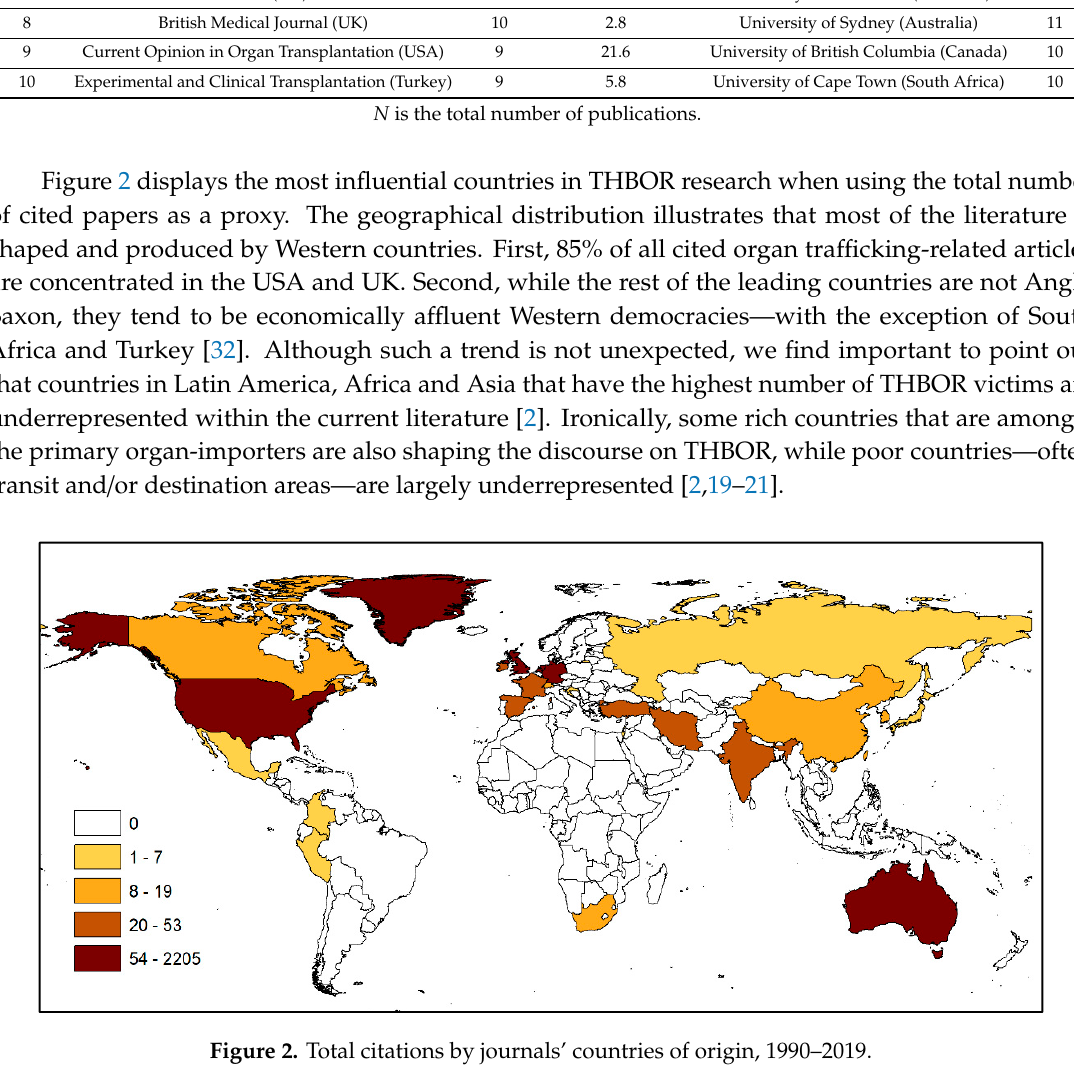
Figure 2. Total citations by journals’ countries of origin, 1990–2019.